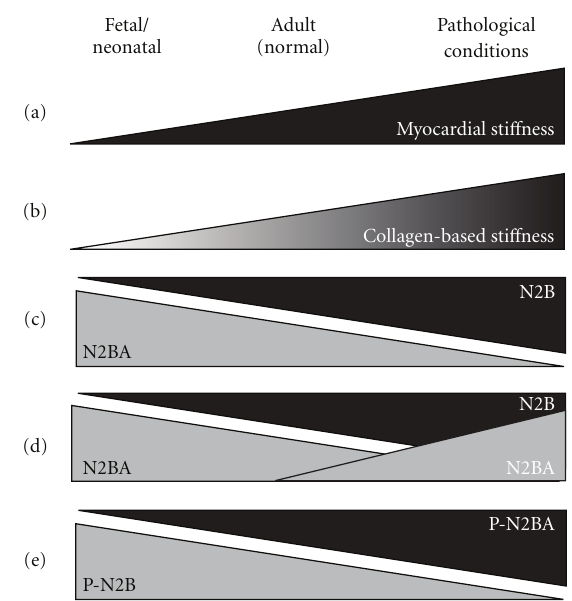
Figure 2: Progressive increase in myocardial (a) and collagen-based sti ff ness (b) during physiologic cardiac growth as well as HF or HF-associated pathological conditions. The increase in myocardial sti ff ness can be paralleled by a concordant increase in the expression of the sti ff titin isoform N2B (c) or by a compensatory increase in the expression of the compliant titin isoform N2BA (d). Relative hypophosphorylation of the sti ff N2B titin also accounts for an increase in myocardial sti ff ness in HF, especially in HFNEF (e) (P- N2B: phosphorylated N2B; P-N2BA: phosphorylated